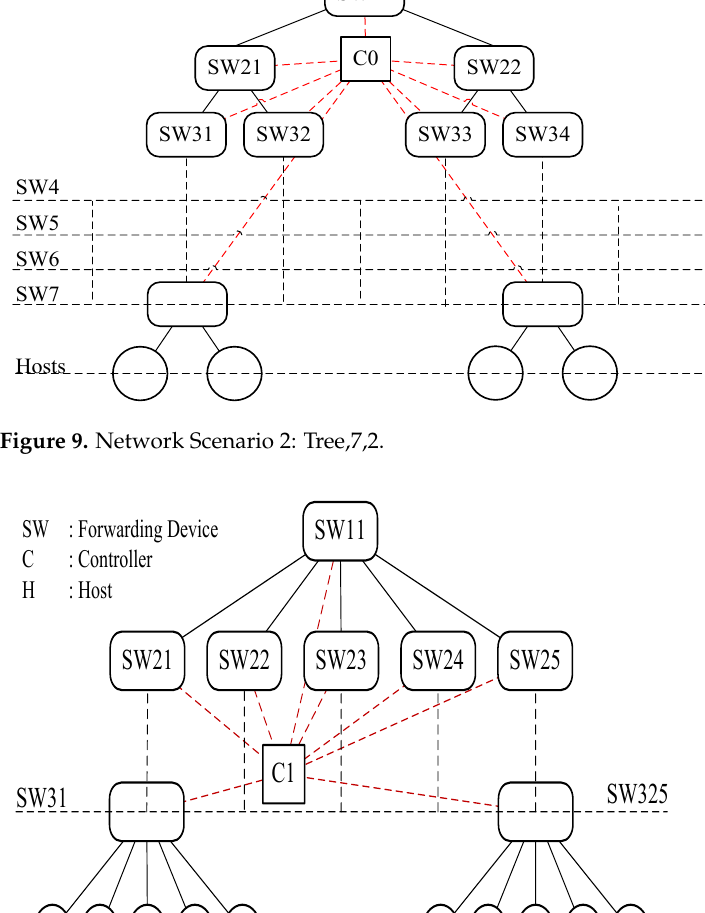
O F S w it c h S 2 Figure 11. Network Scenario 4: Hybrid. At the absolute least, one OFSwitch is linked to each and every switch. Connected hosts and switches are represented by the numbers H1 through H30. Information on the hardware and software, SDN controllers, software library, network analyzer tools, and other resources used for SDN validation [31] is summarized in Table 7. During testing, we simulated assaults using the Scapy software library.